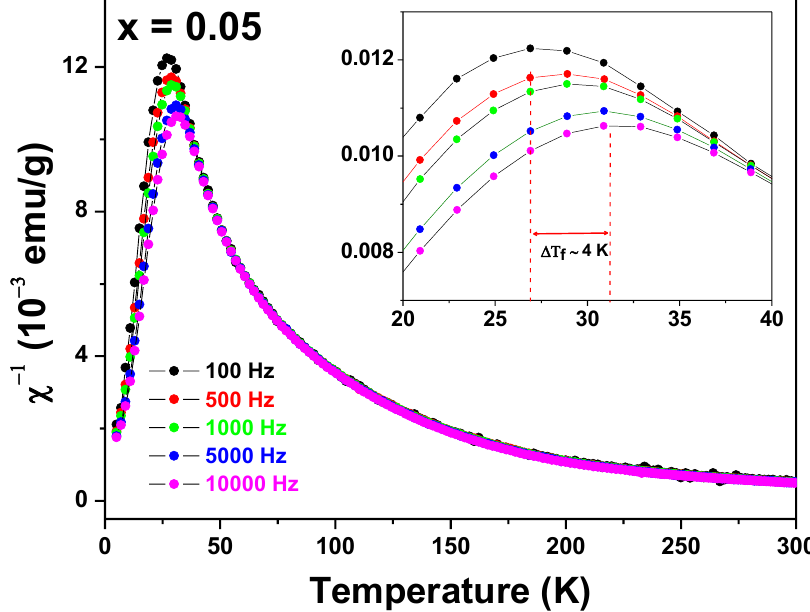
Figure 5. AC magnetic susceptibility χ (cid:48) (T, f) curves of the Zn 0.95 Fe 0.05 O sample. The frequencies are shown in the figure. The insert displays the peak shifting effect due to the frequency change of the experiment.